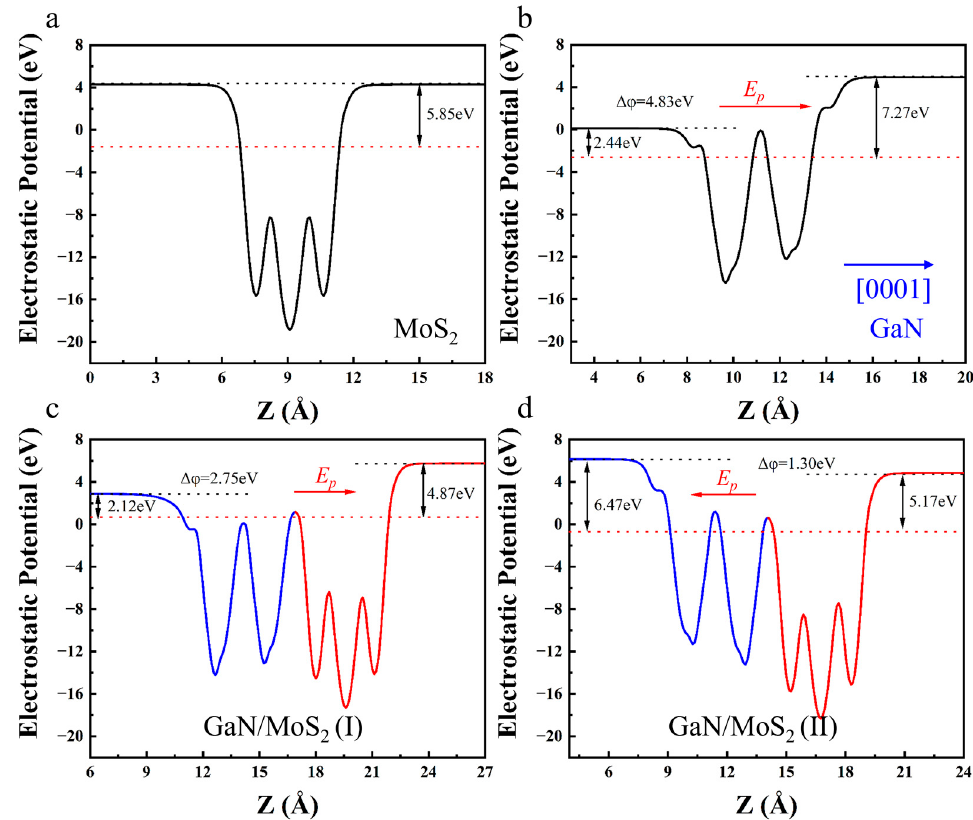
Figure 3. Planar average electrostatic potentials of ( a ) MoS 2 monolayer, ( b ) GaN, ( c ) GaN/MoS 2 (I), and ( d ) GaN/MoS 2 (II) heterostructures along z-direction, respectively. In ( c ) and ( d ), the blue and red parts of the electrostatic potential curves correspond to GaN and MoS 2 , respectively. The red and blue arrows indicate the directions of the polarization-induced electric fields and [0001] polarity axis, respectively. The vacuum levels and Fermi levels are marked with black and red dashed lines,